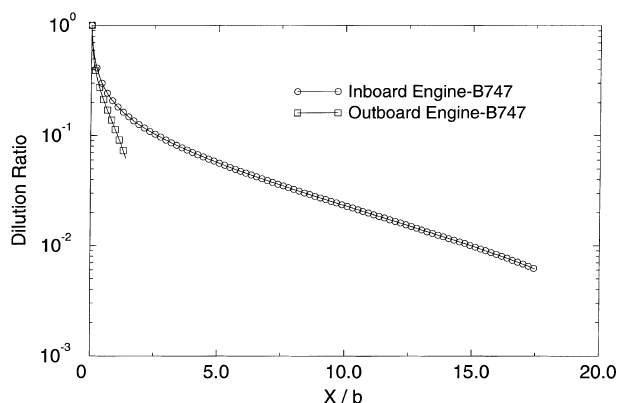
Fig. 7. Dilution ratio profiles comparing the inboard and outboard engine jet results for a four-engine Boeing 747. Calculated from integral model